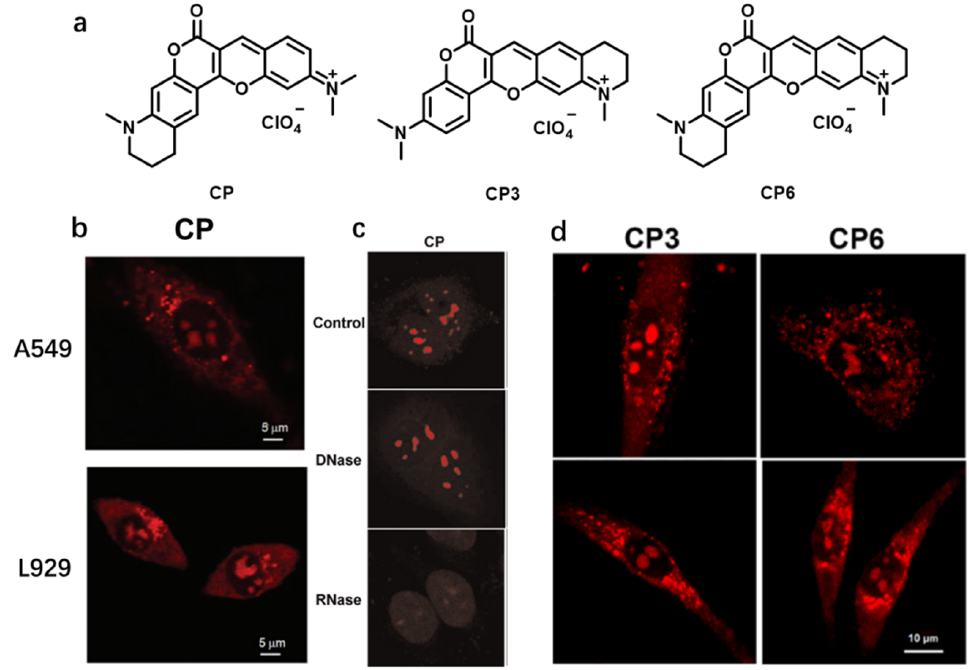
Figure 9. ( a ) Structures of CP, CP3 and CP6. ( b , d ) Live cell imaging of A549 and L929 cells with CP, CP3 and CP6. [CP] = 5 μM, [CP3] = 7 μM, and [CP6] = 7 μM. ( c ) DNase and RNase digest experi- ments. Reproduced from [36] and [37] with permission from Elsevier, Copyright 2015 and the Amer-